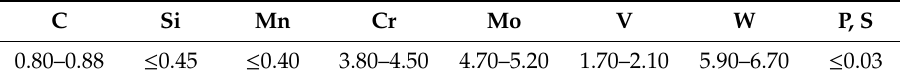
Table 1. Chemical composition of SKH51